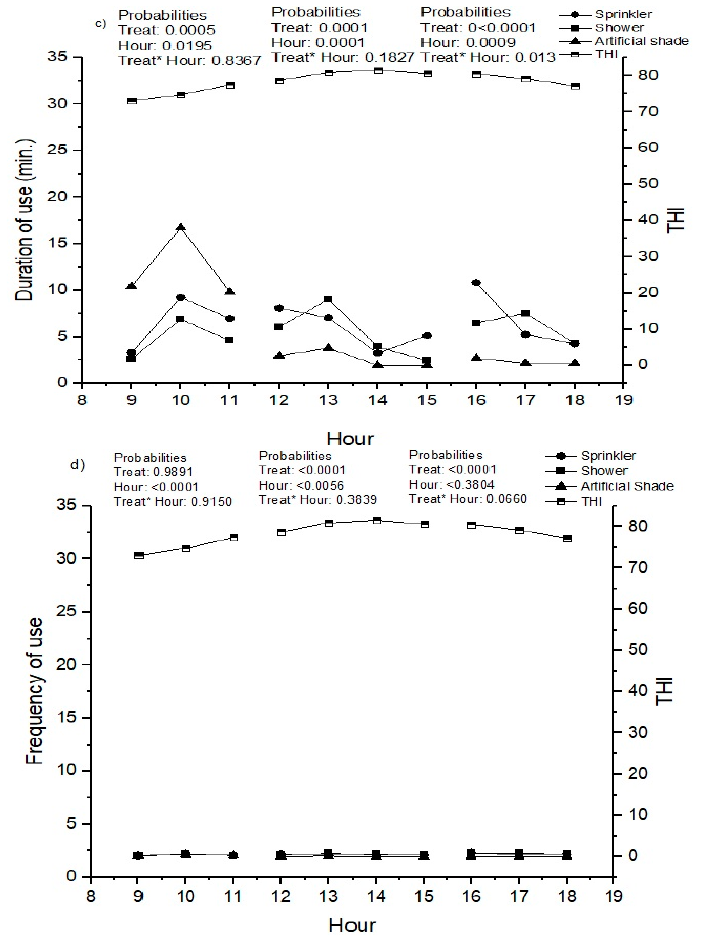
Figure 3. ( a ) Influence of duration of use (minutes) of sprinkler, shower, and artificial shade systems in relation to the hour of the day ( y axes: duration of use, temperature, and humidity); ( b ) Influence of frequency of use of sprinkler, shower, and artificial shade systems in relation to the hour of the day ( y axes: frequency of use, temperature, and humidity); ( c ) Influence of duration of use (minutes) of sprinkler, shower, and artificial shade systems in relation to the hour of the day ( y axes: duration of use and THI); ( d ) Influence of frequency of use of sprinkler, shower, and artificial shade systems in relation to the hour of the day (frequency of use and THI).